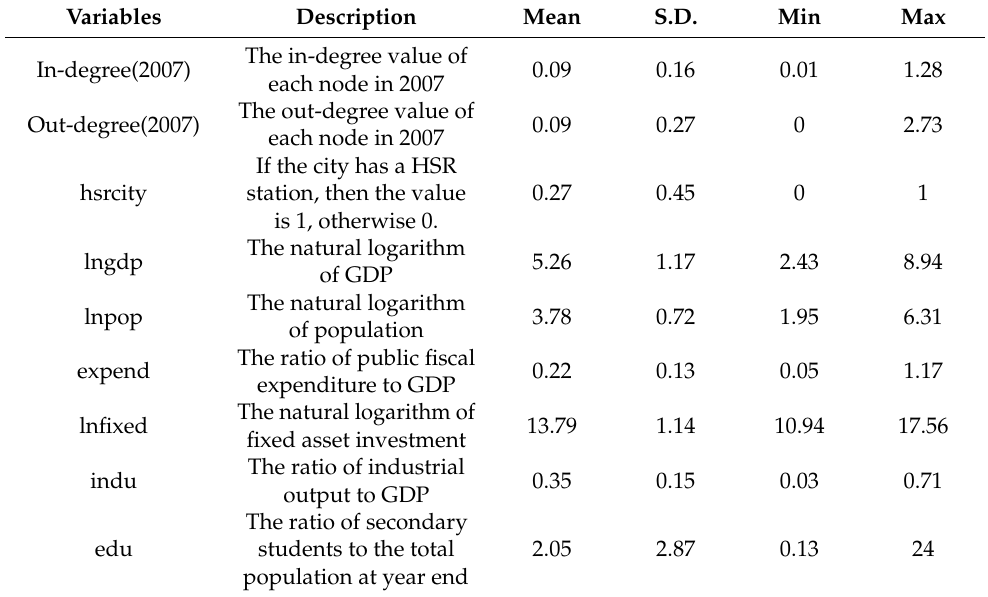
Table 1. Descriptive statistics of all exploratory